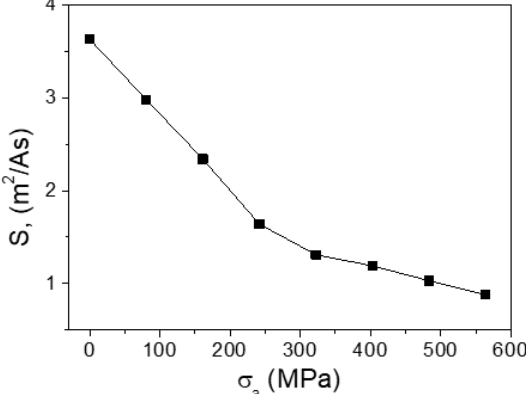
Figure 7. Dependence of DW mobility of microwires № 2 on tension stress. Reprinted with permission from [6].